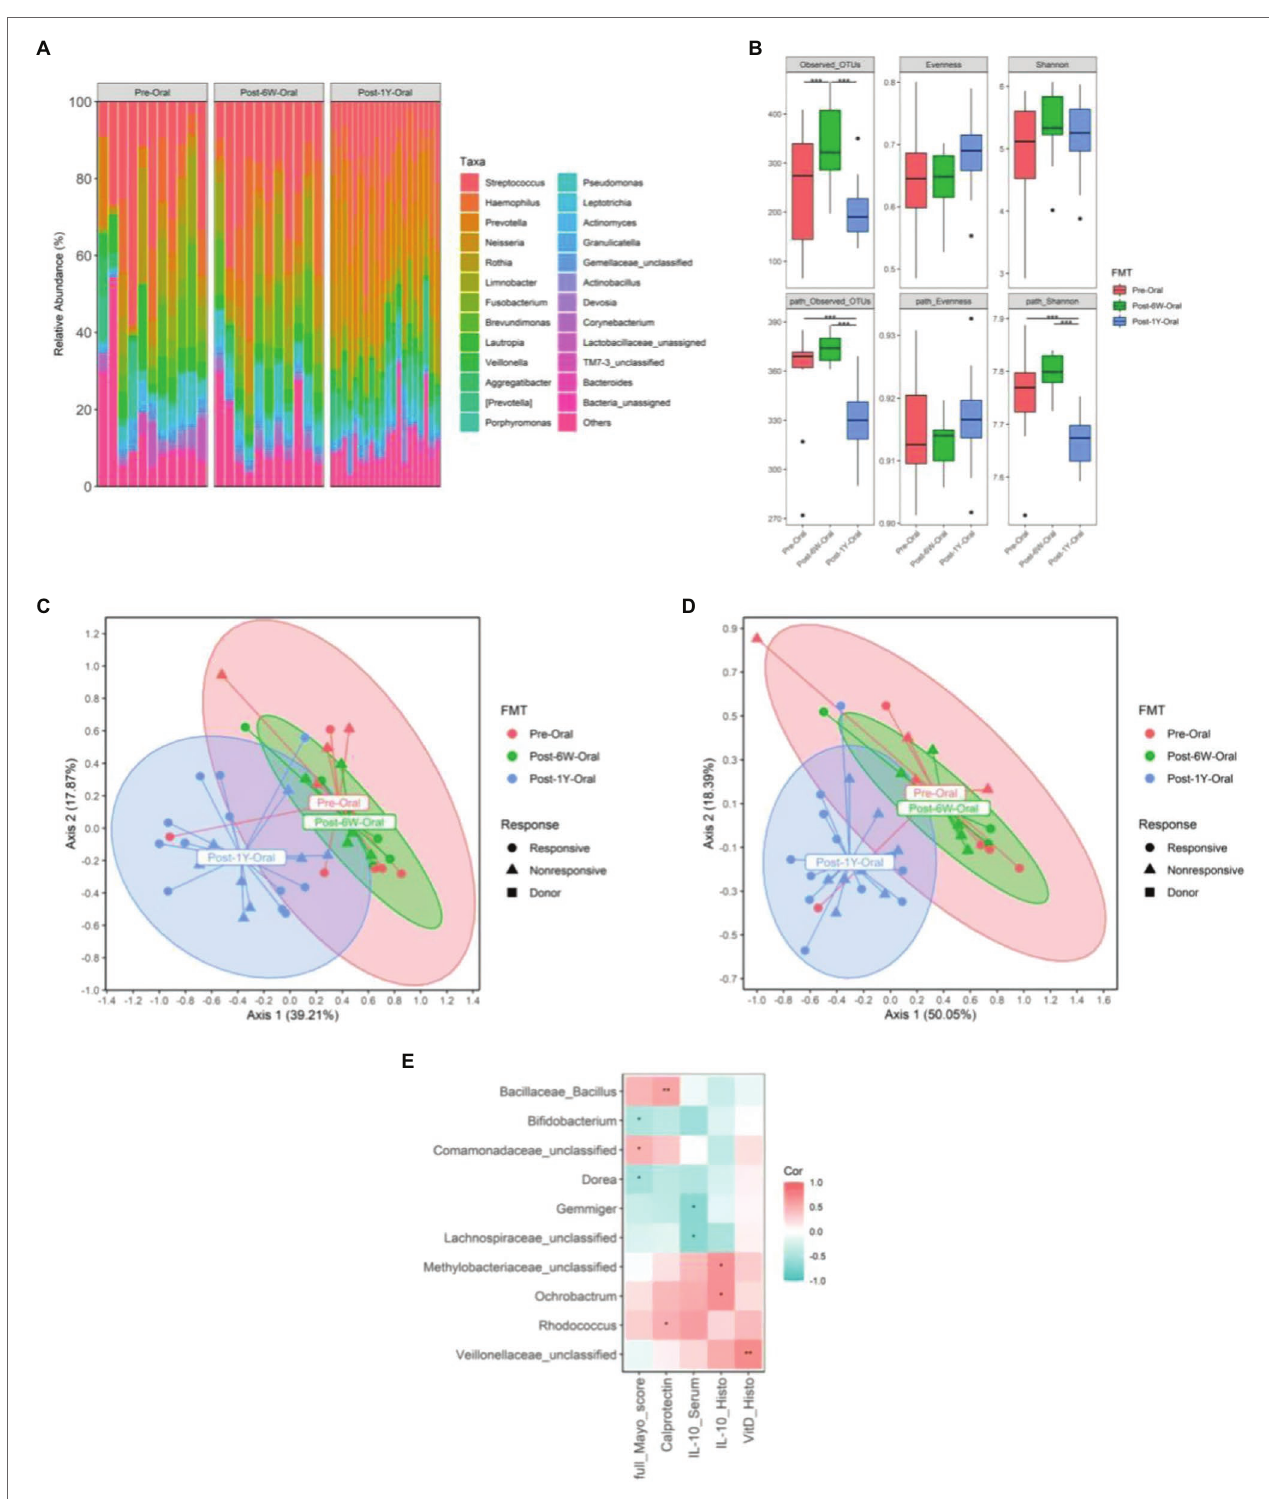
FIGURE 7 | The change of oral microbiota from all patients. (A) The relative abundance of oral microbiota in each patient throughout the clinical study. (B) The alpha diversities of oral microbiota throughout the clinical study. (C) PCoA based on weighted UniFrac matrix of bacterial taxonomy. (D) PCoA based on Bray-Curtis matrix of predicted pathways. (E) The correlation coefficients between biomarkers and oral microbiota at genus level. Boxplots present the median and interquartile range (25–75th percentiles) for each group with whisker length equal to 1.5 interquartile range. The Spearman correlation coefficients were calculated and labeled in the figure. Statistically significances are also indicated: * p < 0.05, ** p < 0.01, and *** p <